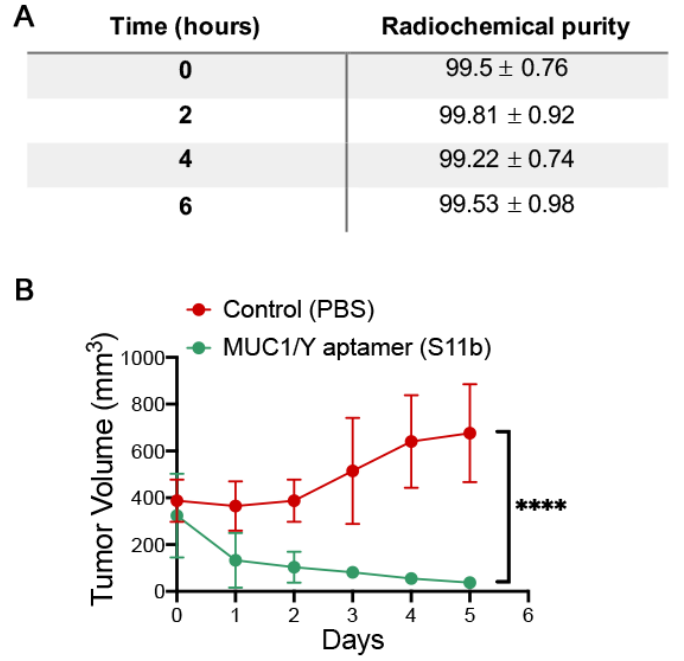
Figure 6. ( A ) Radiochemical purity of S11b- 99m Tc aptamer at 0, 2, 4 and 6 h post-labelling in saline. ( B ) Tumour growth curve of MDA-MB-231 tumour-bearing NOD-scid mice control (red) and treated with 100 mg/Kg of S11b aptamer (green). Data are the mean (S.D.), n = 5. Data were analysed by a non-linear regression model. **** p < 0.05.